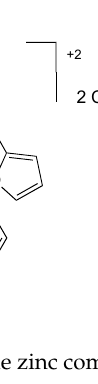
Figure 7. Structure of the zinc complexes 10 and 11 . The bidentate quinolin-4(3 H )-one based Schiff base ligand L 11 and its 1,10-phenanthroline zinc complex 11 (Figure 7) have been screened for their in vitro cytotoxic activity against the human breast cancer MCF-7 cell line [116]. Even if the antiproliferative activity of metal complexes is often due to the synergistic effect produced by the metal core and the ligands, the free ligand L 11 resulted inactive against MCF-7 cells. On the basis of these findings, the noteworthy anticancer activity of 11 may be due to phen moiety or to the metal center zinc(II). In fact, complex 11 exhibited interesting anticancer activity against MCF-7 cells (GI 50 = 0.016 µM) even at lower GI 50 value than the reference drug